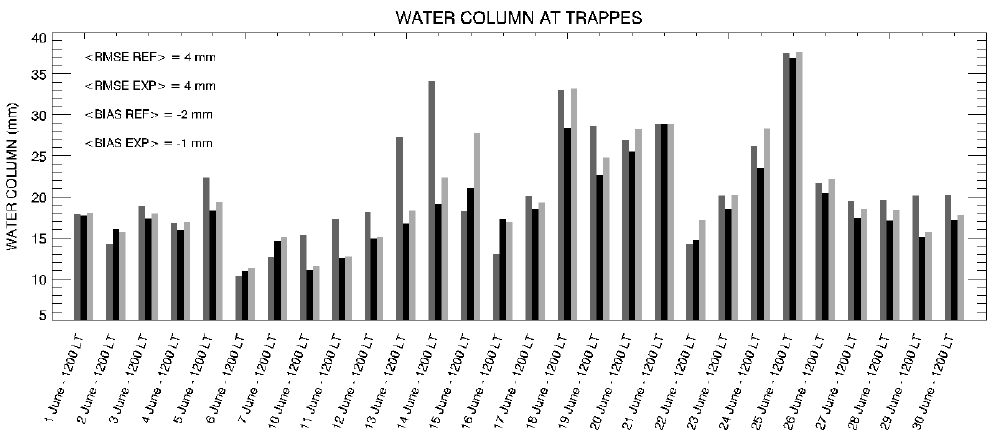
Figure 5: The water column at Trappes from radio-sounding measurements (dark grey bars), the Reference simulation (black bars) and the COT assimilation experiment (light grey bars).